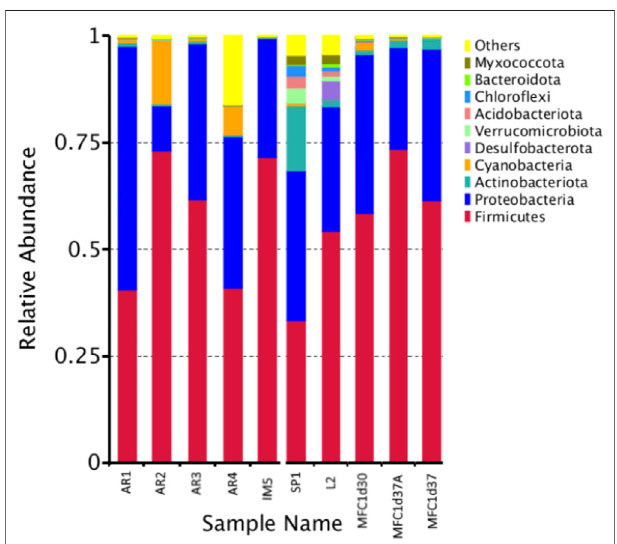
FIGURE 10 | Relative abundance at the level of Phylum from native microbial communities. Samples AR1 – AR4 correspond to wastewater obtained at different stages of the process Washing, Fermentation, Leachate and Mixed, respectively, and as shown in the scheme in Figure 1 . Sample IM5 is the mixture of the wastewater from all sampling points. Sample SP1 is a sample from soil associated to coffee plants. Sample L2 is a sample from soil not related to coffee farms, used as a comparison. Samples MFC1d30 and MFC1d37 are sample from the anolyte from MFC1 at 30 and 37 days of operation, respectively. Sample MFC1d37A is a sample form the anodic bio fi lm from MFC1 at 37 days of